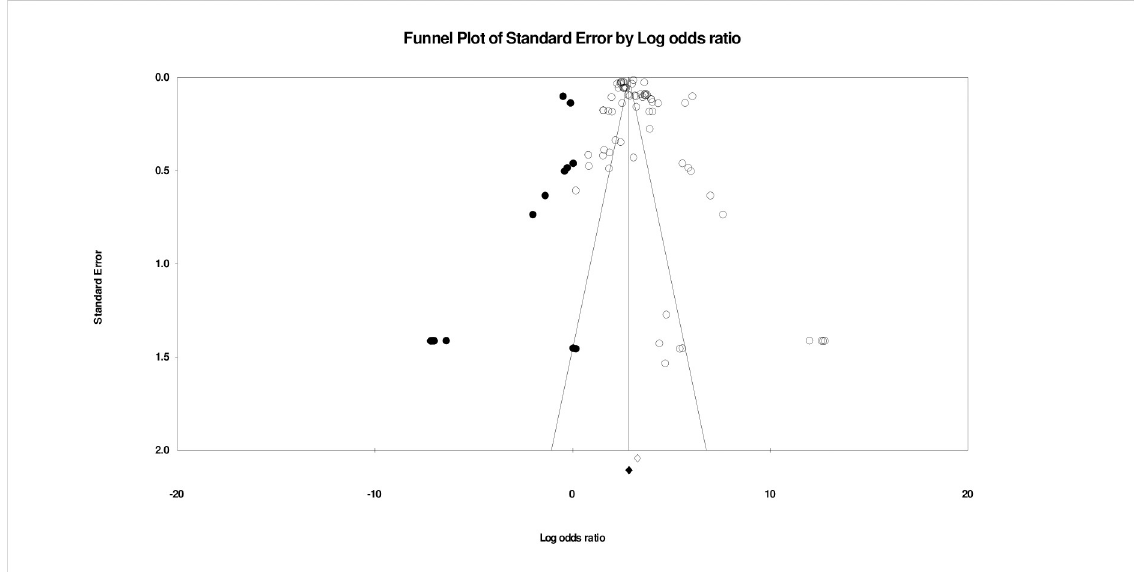
Fig 5. Publication bias of effect sizes related to machine learning prediction of